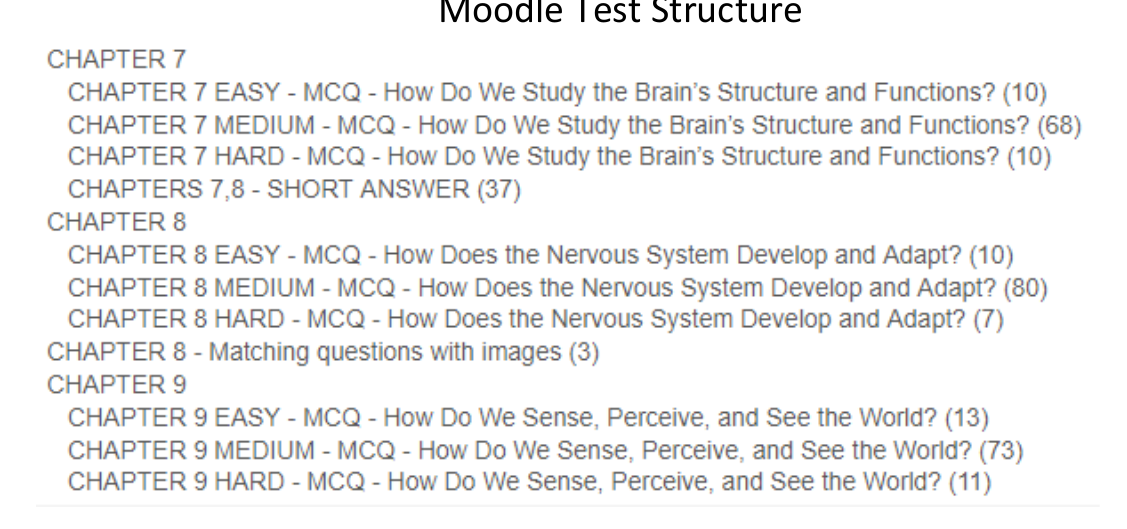
Figure A1. Moodle question bank with questions sorted based on cognitive difficulty level.